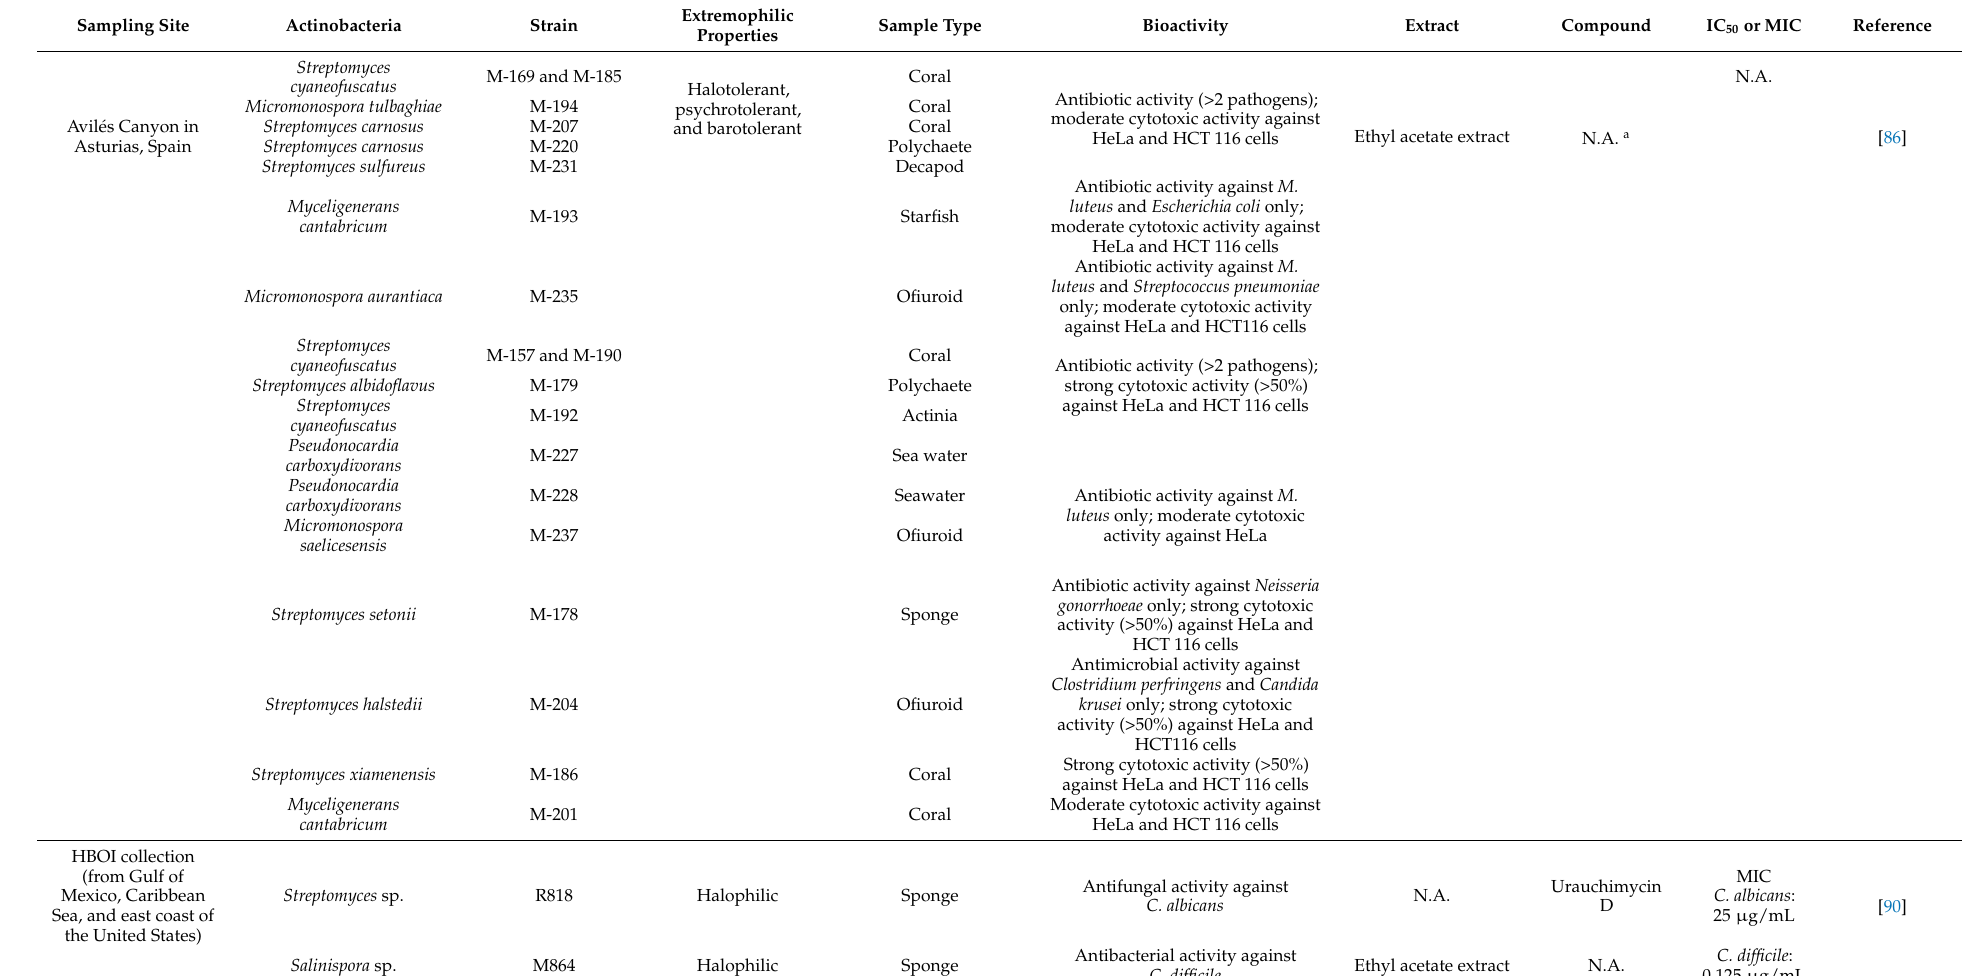
Table 2. Bioactivity of actinobacterial strains isolated from the deep-sea